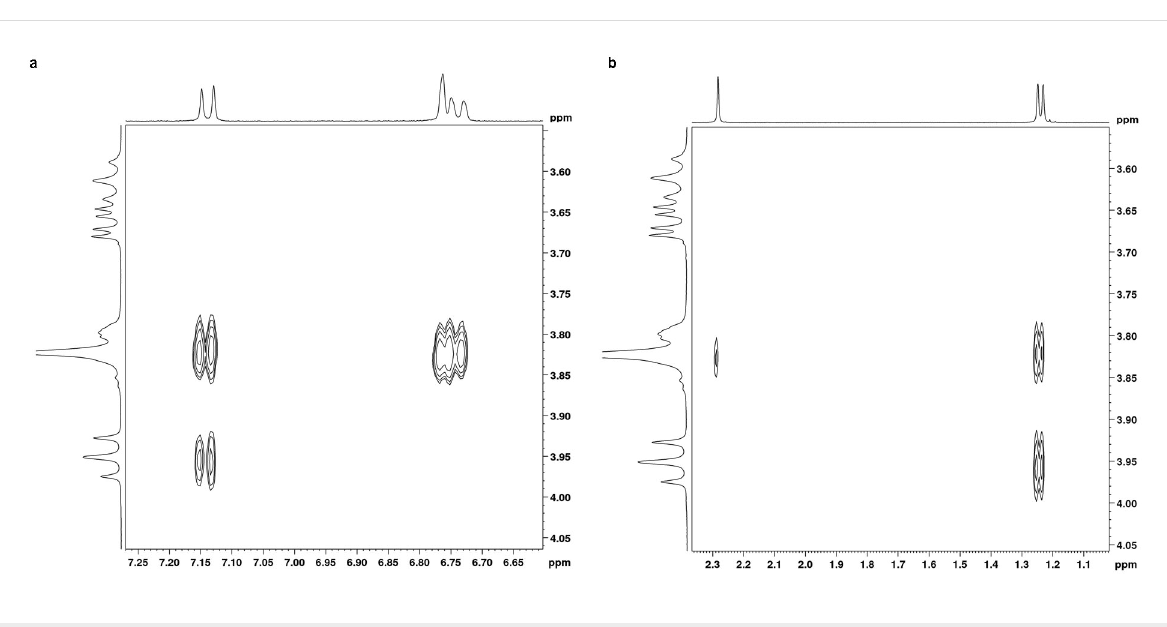
Figure 6: 2D ROESY plots of β -CD/thymol ( 2 ) complex in D 2 O showing the NOEs between the H-3 and H-5 protons of β -CD and (a) the aromatic protons and (b) the aliphatic protons of thymol ( 2 ).